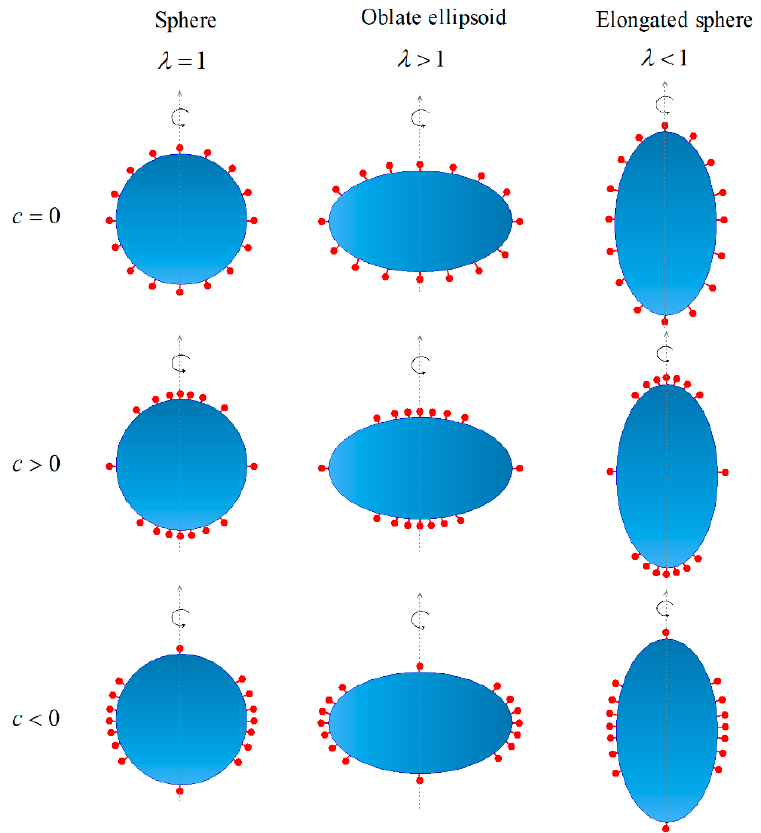
Figure 2. Schematic on how the dimensionless constant c determines the ligand pattern on the surfaces of NPs with different shapes.